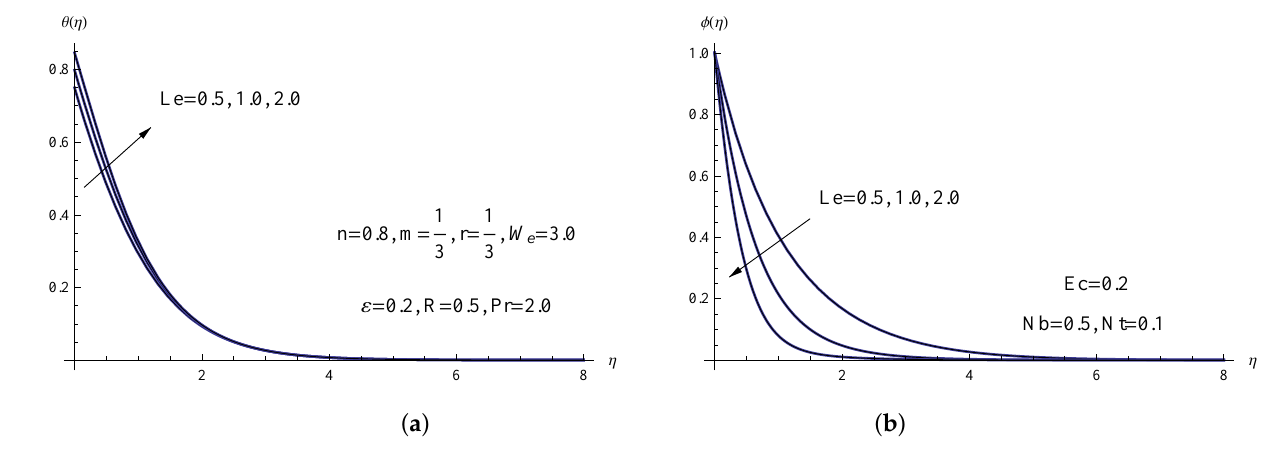
Figure 10. ( a ) θ ( η ) via Le ; ( b ) φ ( η ) via Le